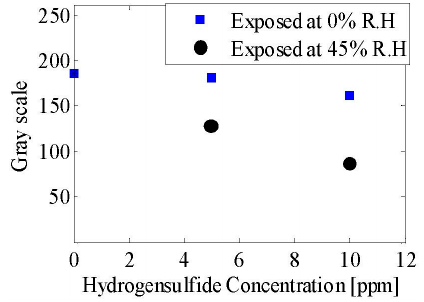
Figure 10. Optical response of the sensor with different concentrations of H 2 S and relative humidity.